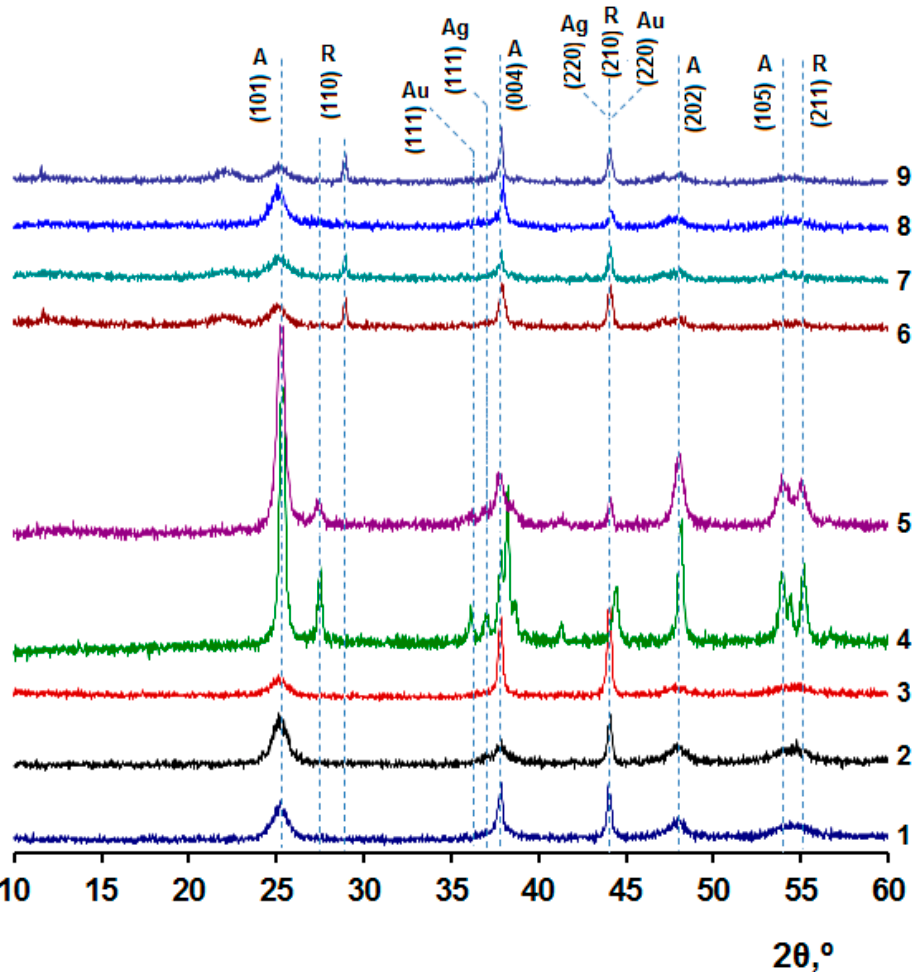
Figure 1. XRD-diffraction patterns after degradation of organic part of samples [( ≡ TiO) n ]:[HEMA]:[M]: curve 1—HEMA, curve 2—BMA, curve 3—AN, curve 4—HEMA + Ag NPs, curve 5—HEMA + НЧ Au, curve 6—BMA + Ag NPs; curve 7—BMA + Au NPs; curve 8—AN + Ag NPs; curve 9—AN + Au NPs. A—anatase, R—rutile, Au—gold, Ag—silver.